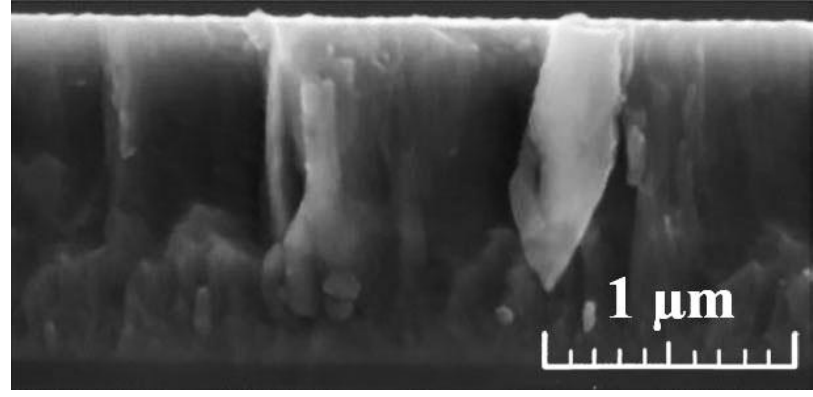
Figure 1. Cross-sectional SEM of the Ti-Al-N film.